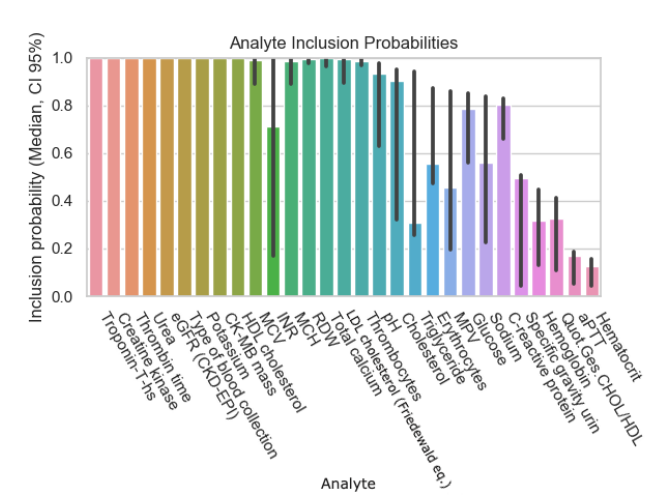
Figure 3. Inclusion probability of parameters based on a subset of the data with (initially) 60% of missing values.